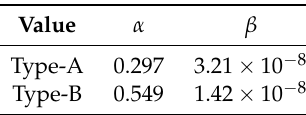
Table 6. The α and β values of Type-A and Type-B structures.